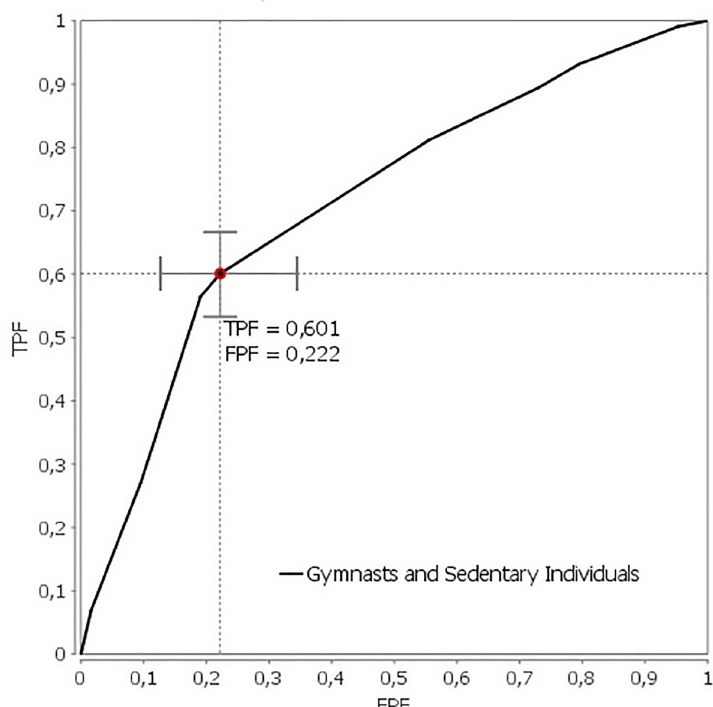
Fig 2. The area under the curve (AUC-ROC) and cut-off point for the epistatic rs1815739 � rs362584 model based on the training dataset.